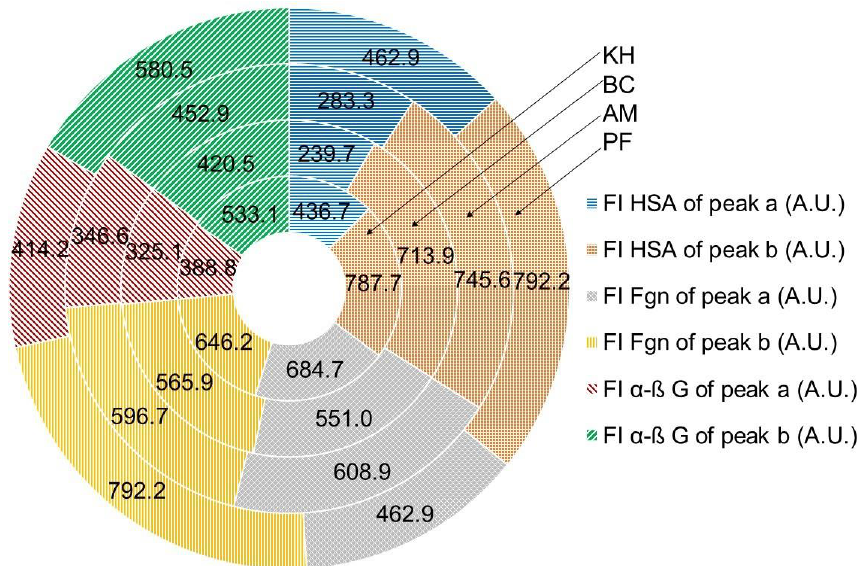
Figure 7. Fluorometric measurements in three-dimensional fluorescence analysis (3D-FL) of kiwifruit and persimmon extracts after interaction with HSA, Fng and α-β-G. Abbreviations: KH, Actinidia (A.) deliciosa cv. Hayward; BC, A. eriantha cv. Bidan; AM, A. arguta cv. Cheongsan; PF, Diospyros kaki Thunb. cv. Fuyu; HSA, human serum albumin, α-β G, α-β-globulin; Fgn, fibrinogen, FI, fluorescence intensity, A.U, arbitral units. The values of fluorescence intensity for used human serum proteins before interaction with extracted proteins were the following: FI HSA of peak a (A.U.) = 545.9; FI HSA of peak b (A.U.) = 814.9; FI Fgn of peak a (A.U.) = 877.4; FI Fgn of peak b (A.U.) = 809.6; FI α-β G of peak a (A.U.) = 457.3; FI α-β G of peak b (A.U.) = 661.1. The locations of peaks a and b are shown in Figures 8 and 9 (for interpretation of the references to color in this figure legend, the reader is referred to the web version of this article).